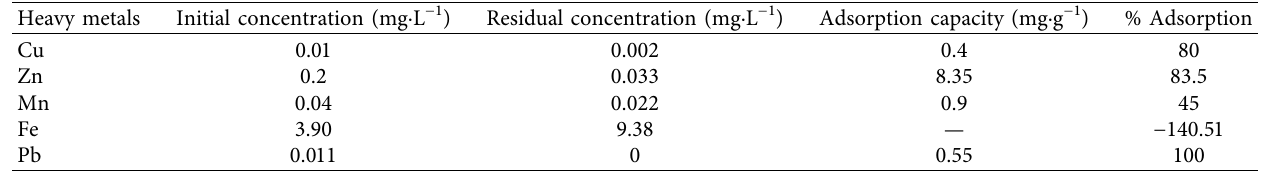
Table 10: Results of the adsorption test by smectic clay: adsorbent mass: 1g.